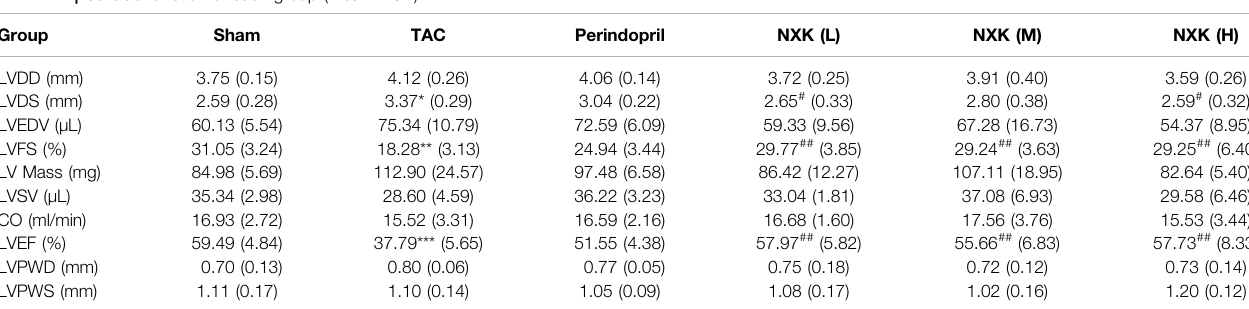
TABLE 1 | Cardiac function of each group (mean ± SD). Group